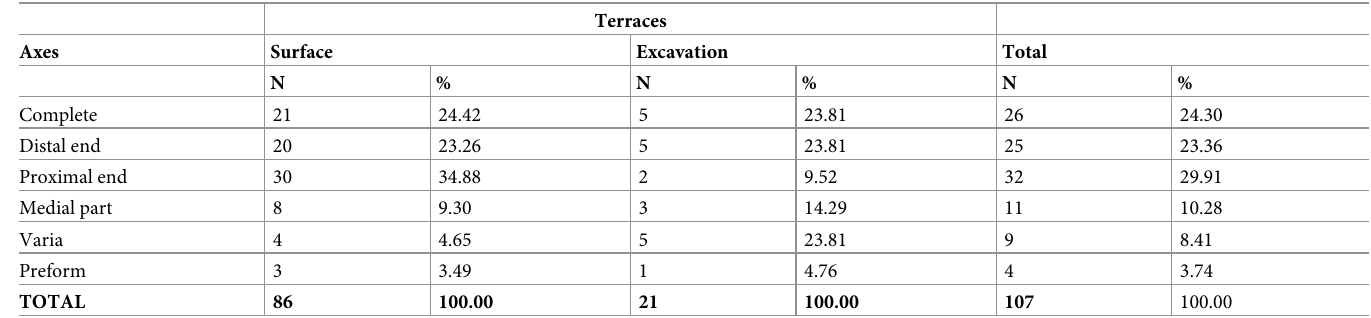
Table 10. Biface distribution in Kaizer Hill Terraces assemblages.